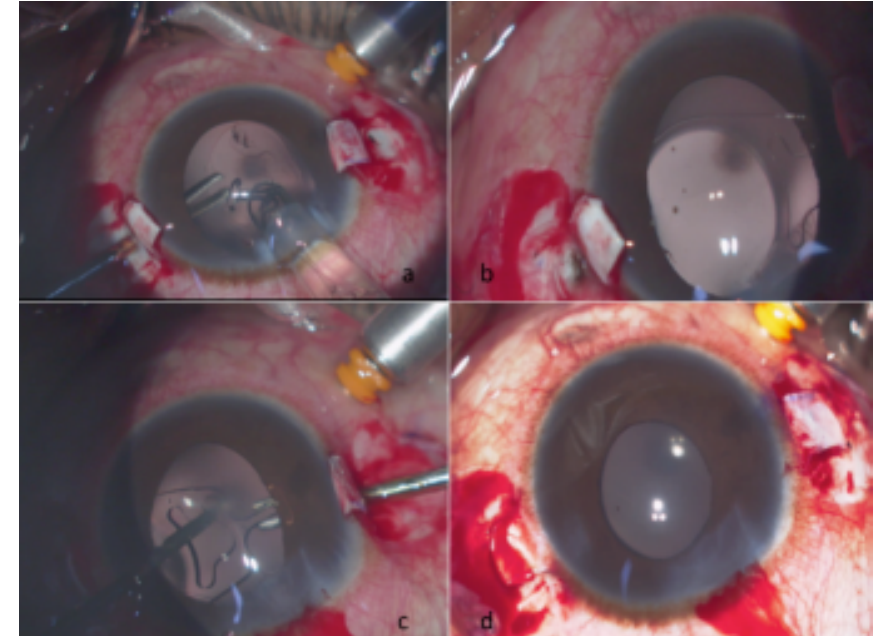
Figure 2: Showing grasping of the T-junction with the PraNIv T-flex forceps (A), exteriorized leading haptic under the scleral flap (B), grasping of the lagging haptic by the handshake technique (C) and the exteriorized lagging haptic